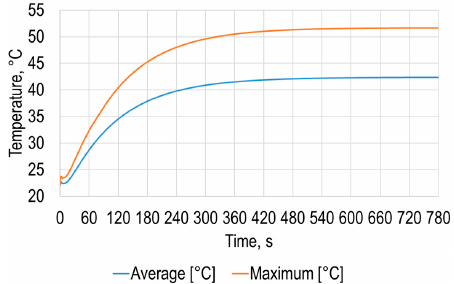
Figure 3. Average and maximum temperatures of the opposite to the heating polymer sheet surface.